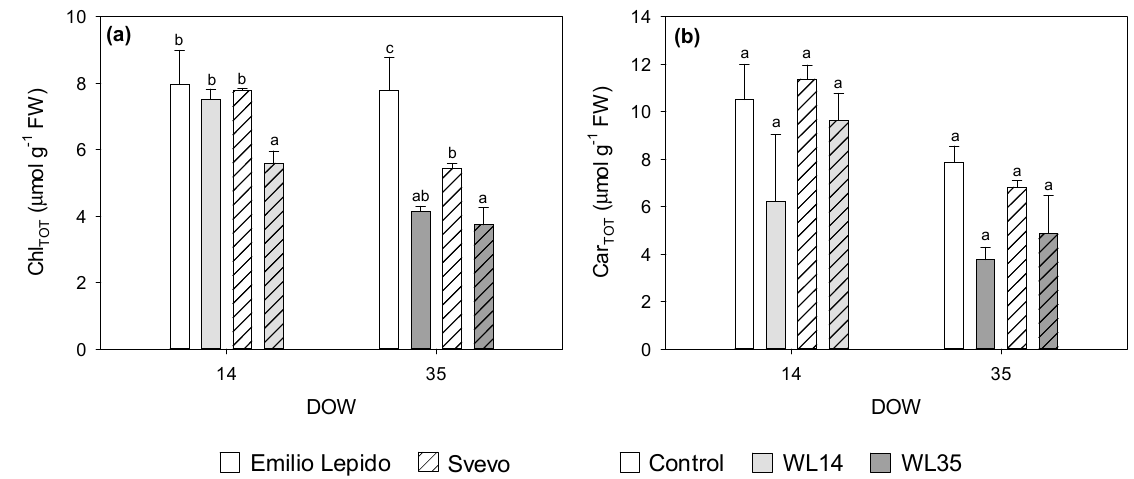
Figure 4. ( a ) Total chlorophyll (Chl TOT ), and ( b ) total carotenoid (Car TOT ) content in leaves of the durum wheat cultivars Emilio Lepido (solid) and Svevo (pattern) subjected to 0 (i.e., control; white), 14 (i.e., WL14; light gray), or 35 (i.e., WL35; dark gray) days of waterlogging (DOW). Data are mean ± standard deviation. FW: fresh weight. For each waterlogging duration, according to Tukey’s post hoc test ( p ≤ 0.05), different letters indicate significant differences among means ( p ≤ 0.05).